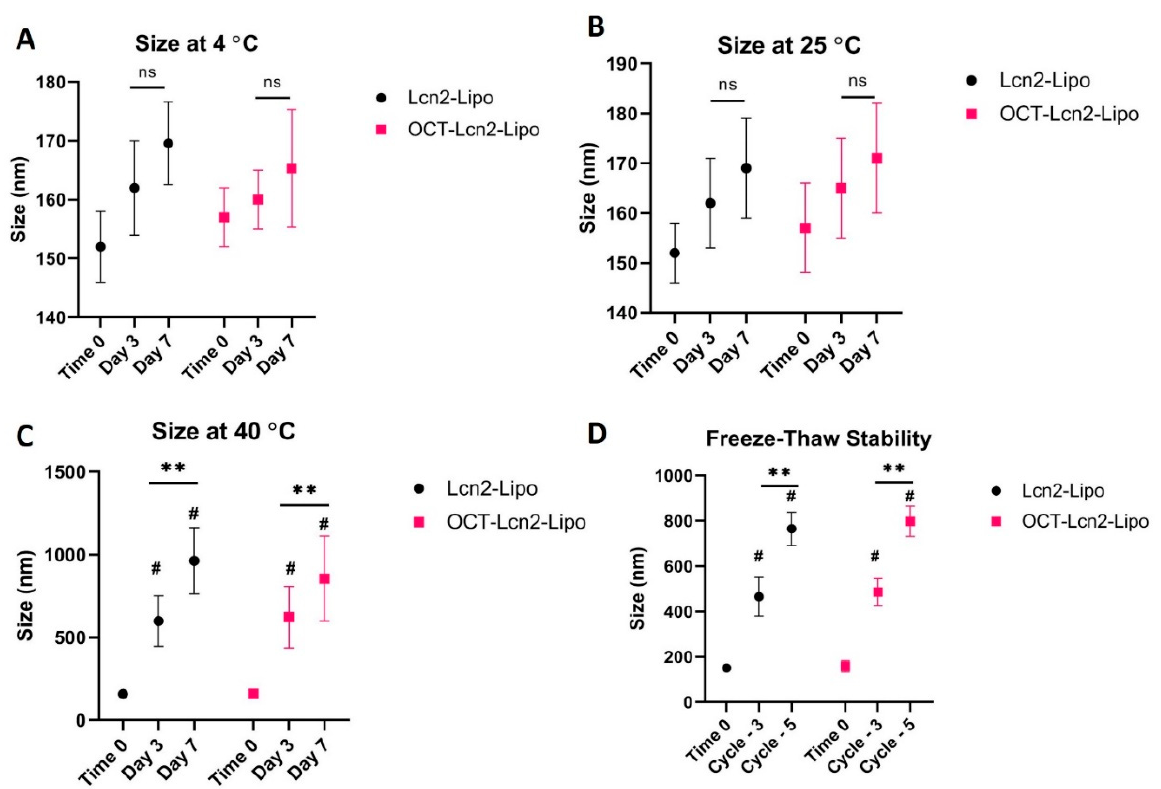
Figure 6. Temperature and freeze-thaw stability study for OCT-Lcn2-Lipo. ( A ) Temperature stability study for OCT-Lcn2-Lipo and Lcn2-Lipo at 4 ◦ C, ( B ) Temperature stability study for OCT-Lcn2-Lipo and Lcn2-Lipo at 25 ◦ C, ( C ) Temperature stability study for OCT-Lcn2-Lipo and Lcn2-Lipo at 40 ◦ C, ( D ) Freeze-thaw stability study for OCT-Lcn2-Lipo and Lcn2-Lipo. The data were expressed as mean ± SD ( n = 3). (# p ≤ 0.05 as compared to Time 0, ns = non-significant, ** p ≤ 0.01 as compared to Lcn2-Lipo group).